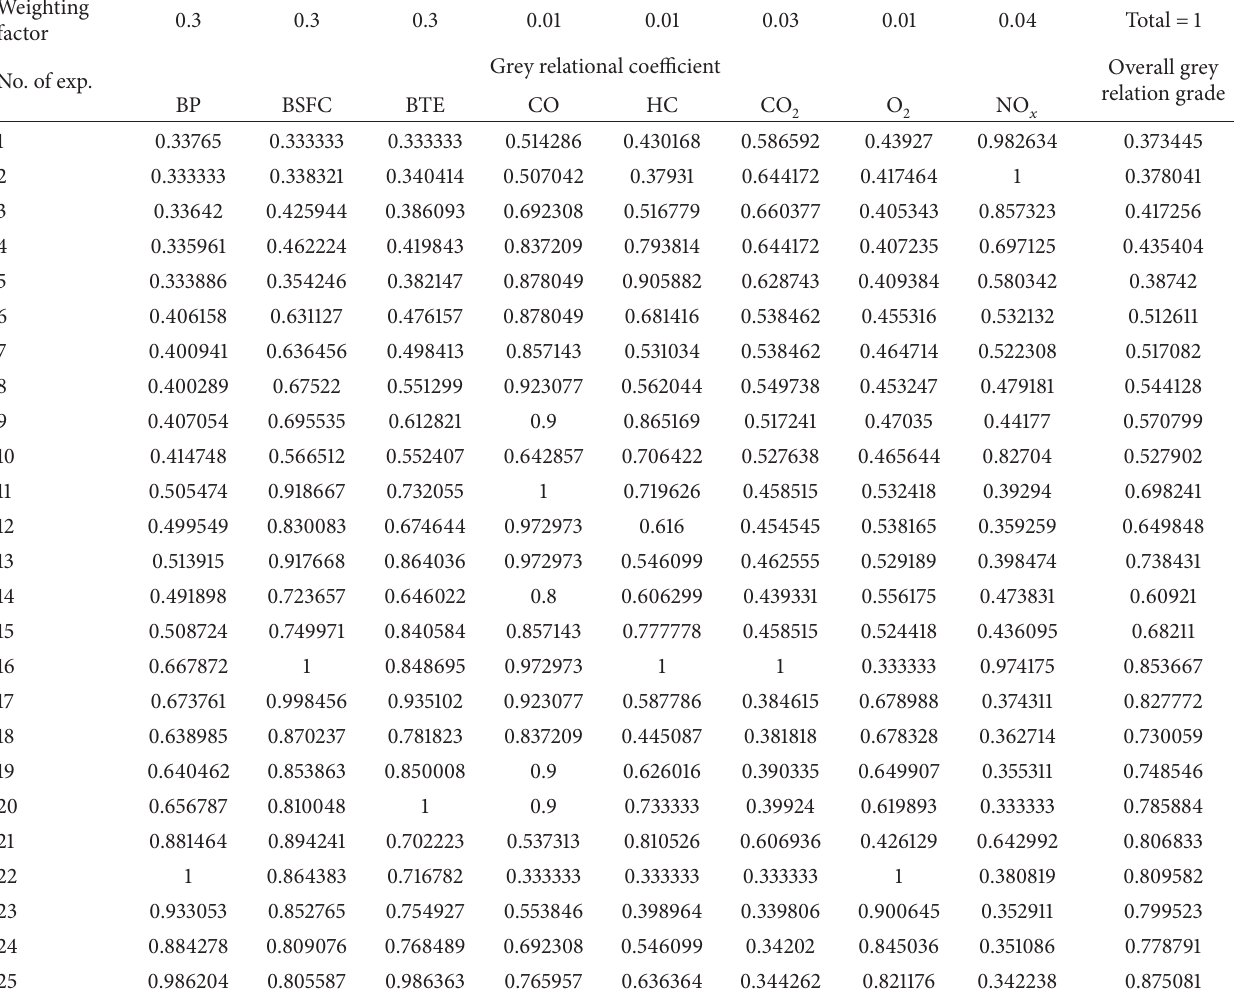
Table 5: Calculated grey relational coefficient of all responses and grey relational grade with weightage.